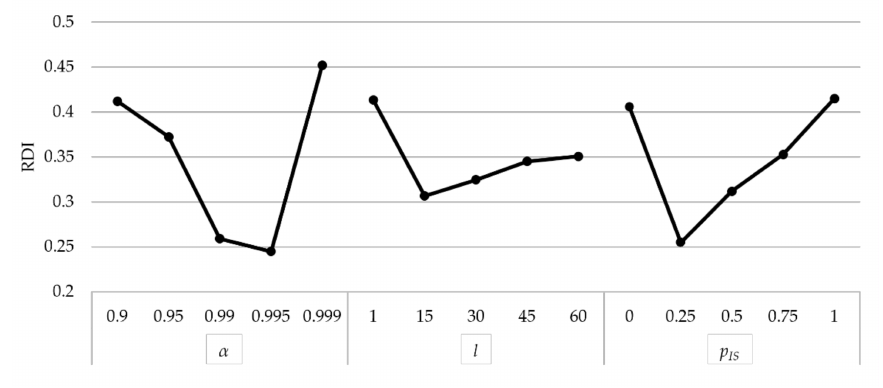
Figure 10. SA calibration. Table 8. Average percentage gaps of heuristic solutions from a solution using CPLEX.